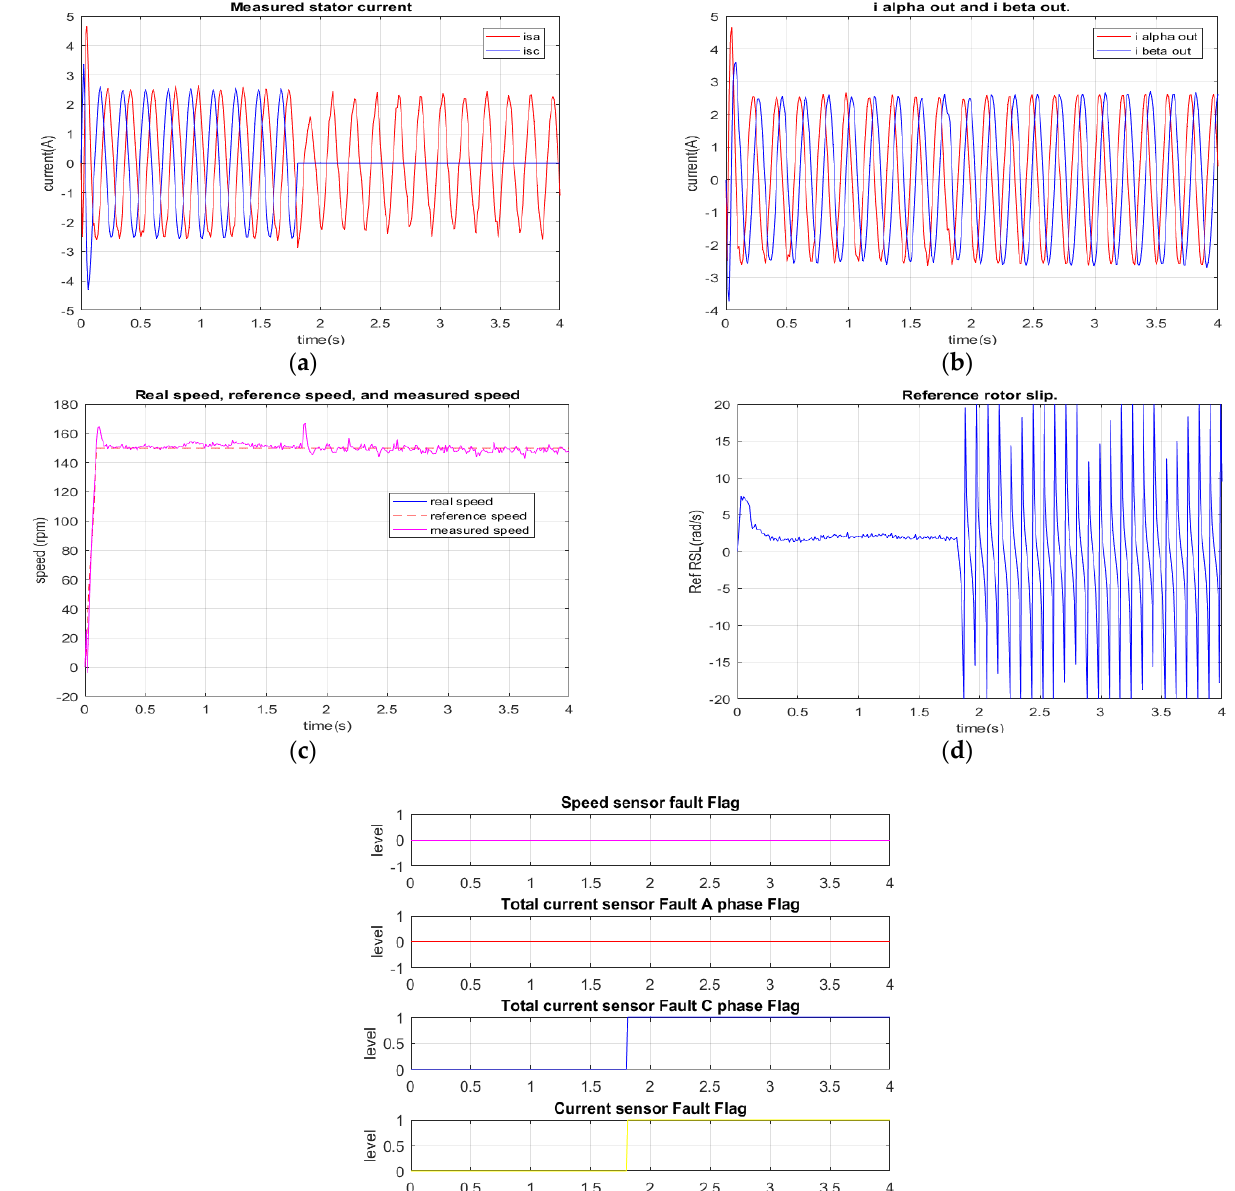
Figure 14. Experimental results: total C phase current sensor failure at 1.8 s. ( a ) Measured currents; ( b ) stator current vector components for FOC controllers (FTC outputs); ( c ) reference, real, measured speeds; ( d ) reference rotor slip; ( e ) sensor fault indications.